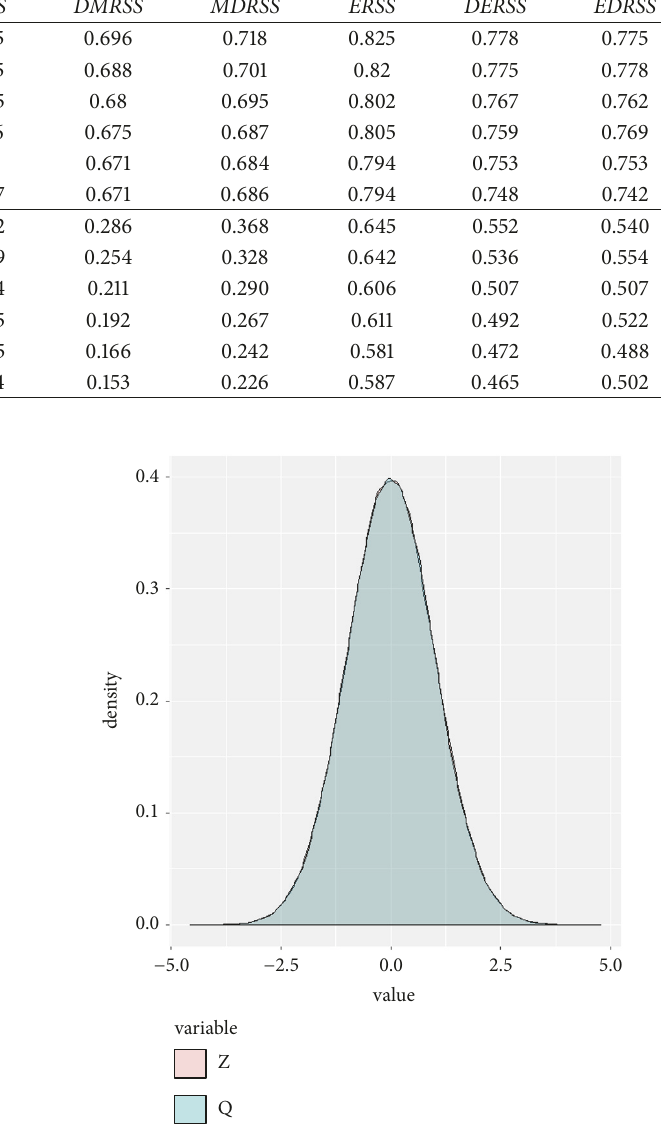
Figure 2: Kernel density plot of 𝑍 and 𝑄 at 𝑛 = 6 , 𝑇 = 𝑅𝑆𝑆 , and 𝜌 = 1 𝑋𝑌